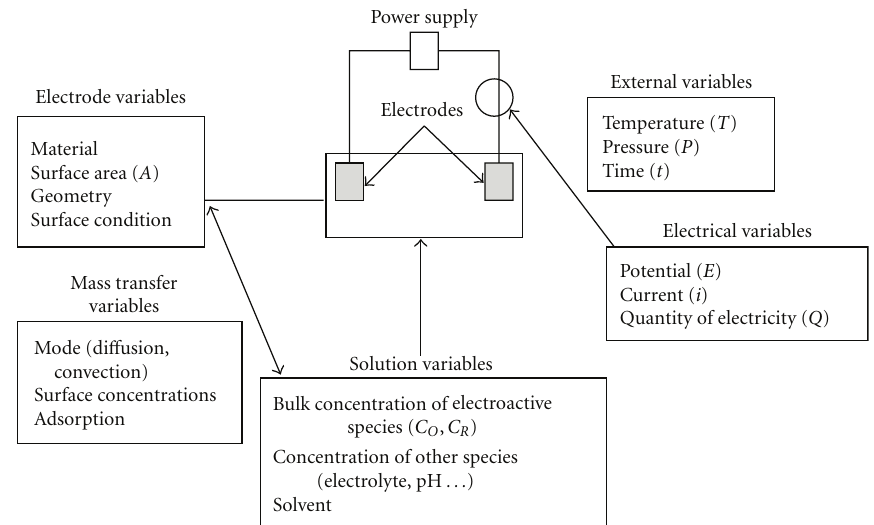
Figure 3: Variables a ff ecting electrochemical phase formation (see